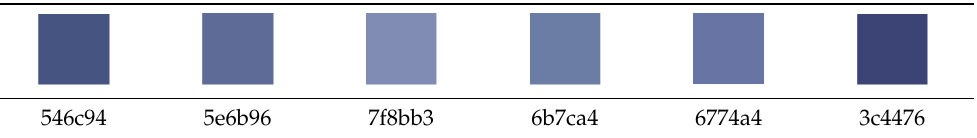
Table 14. Top 3 results for query ‘Blue’ and ‘Dayflower blue’. Query